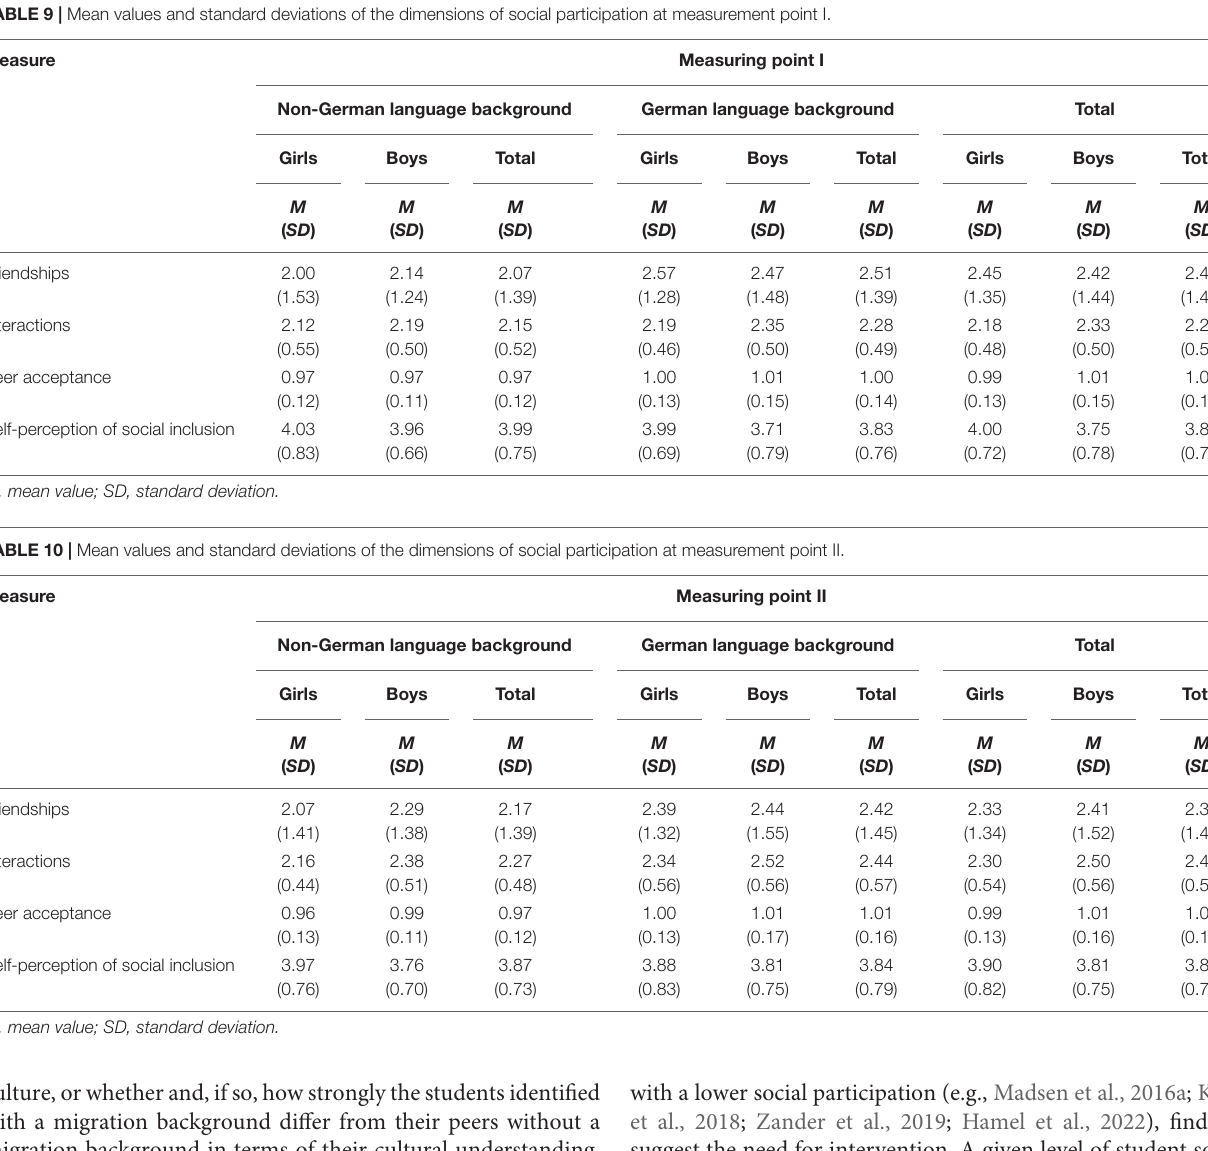
TABLE 9 | Mean values and standard deviations of the dimensions of social participation at measurement point I.